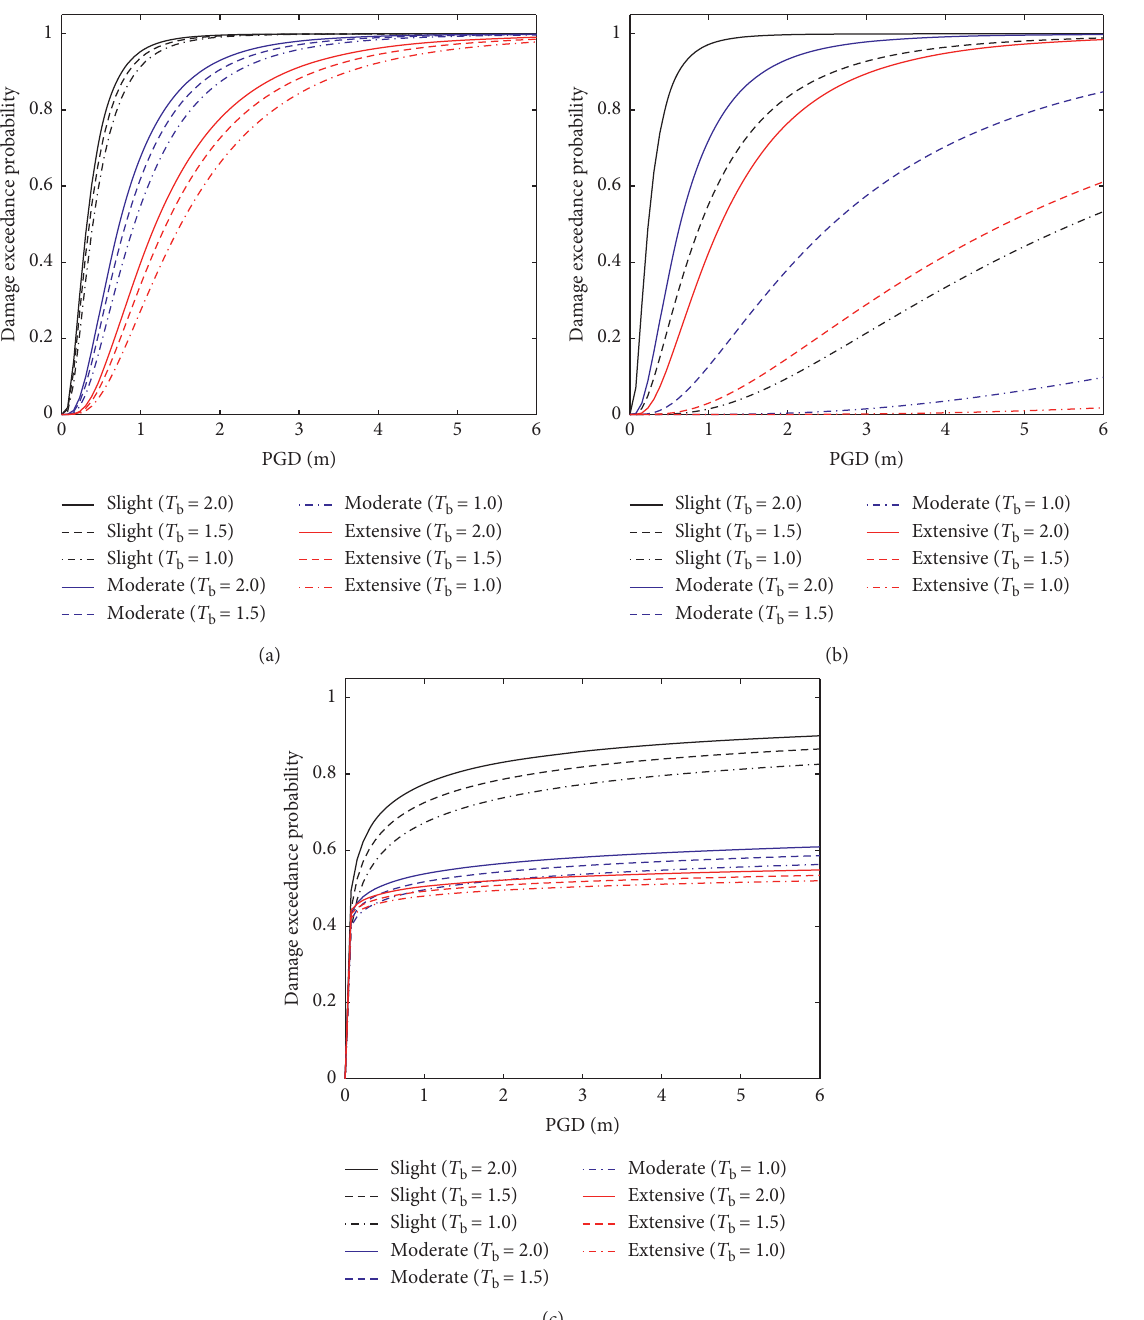
Figure 9: Influence of bearing isolation period on fragility curve: (a) convective displacement; (b) bearing displacement; (c) base shear